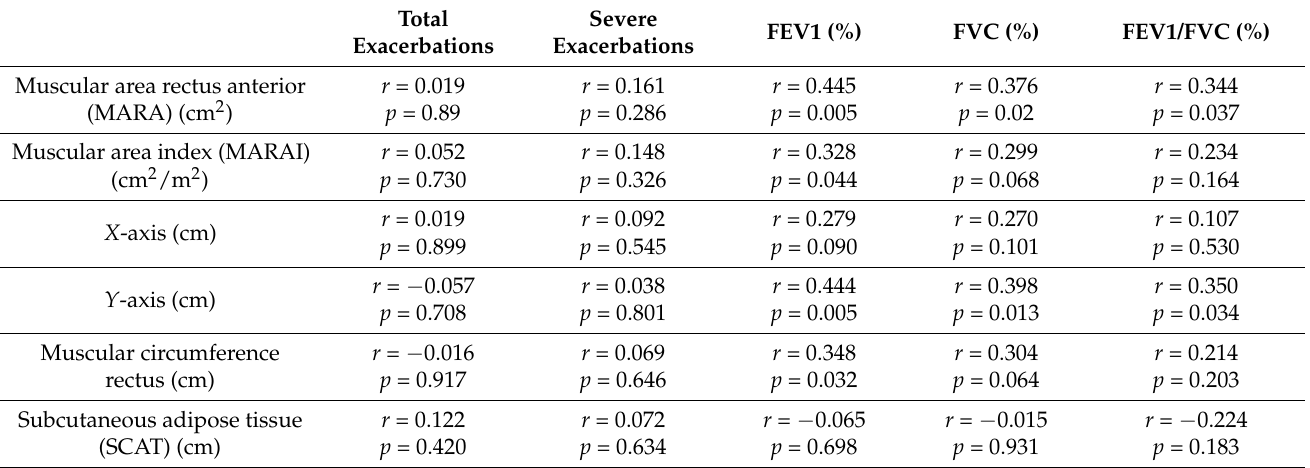
Table 4. Correlations between the ultrasound measurements and the different respiratory